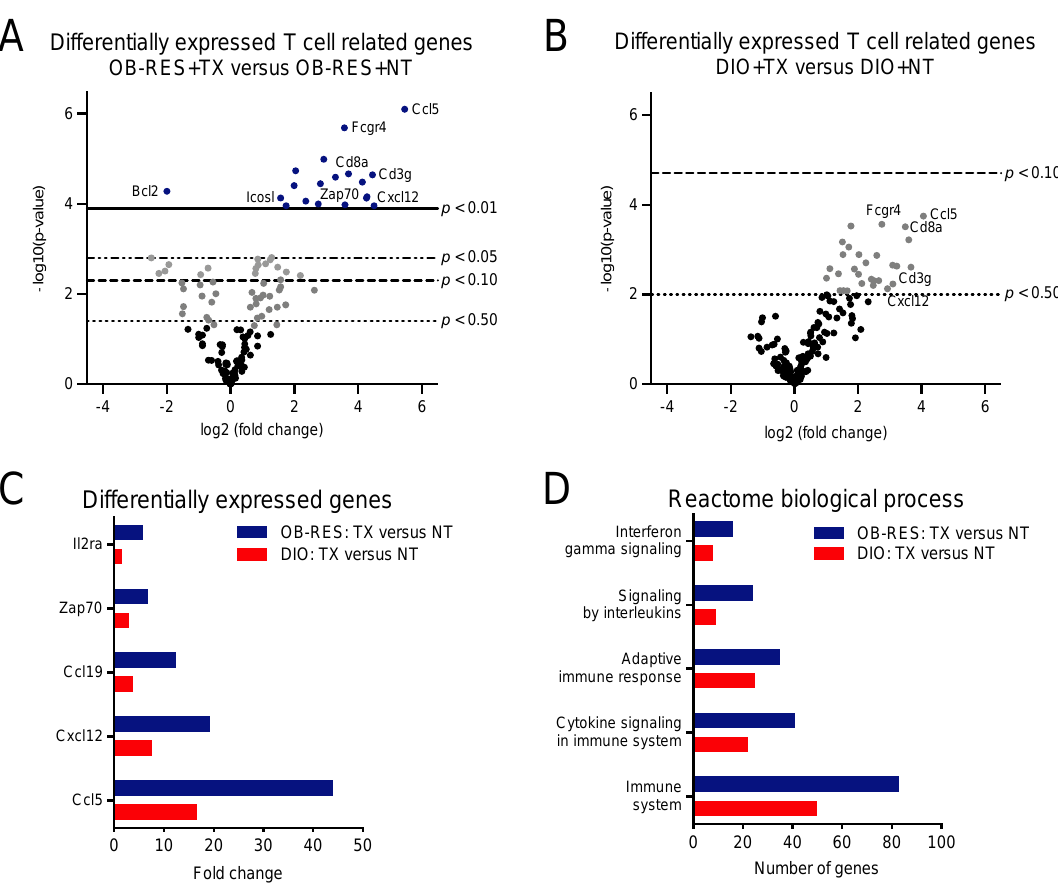
Figure 3. Immunogenetic profiling of renal tumors illustrates that OB-RES mice have a more robust anti-tumor T cell response following therapy administration than do DIO mice. ( A , B ) Volcano plots showing the expression of 153 T cell related genes from tumors harvested at day 21 post-tumor challenge in ( A ) therapy-treated OB-RES versus OB-RES no therapy controls and ( B ) therapy-treated DIO versus DIO no therapy controls (both panels, n = 3–8/group). Lines represent exploratory unadjusted p-value thresholds to screen for differentially expressed target genes. ( C ) Selected differentially expressed genes. ( D ) Differentially expressed T cell related pathways queried using Reactome biological processes. NT: no therapy, TX: AdT/CpG+αCTLA-4 .